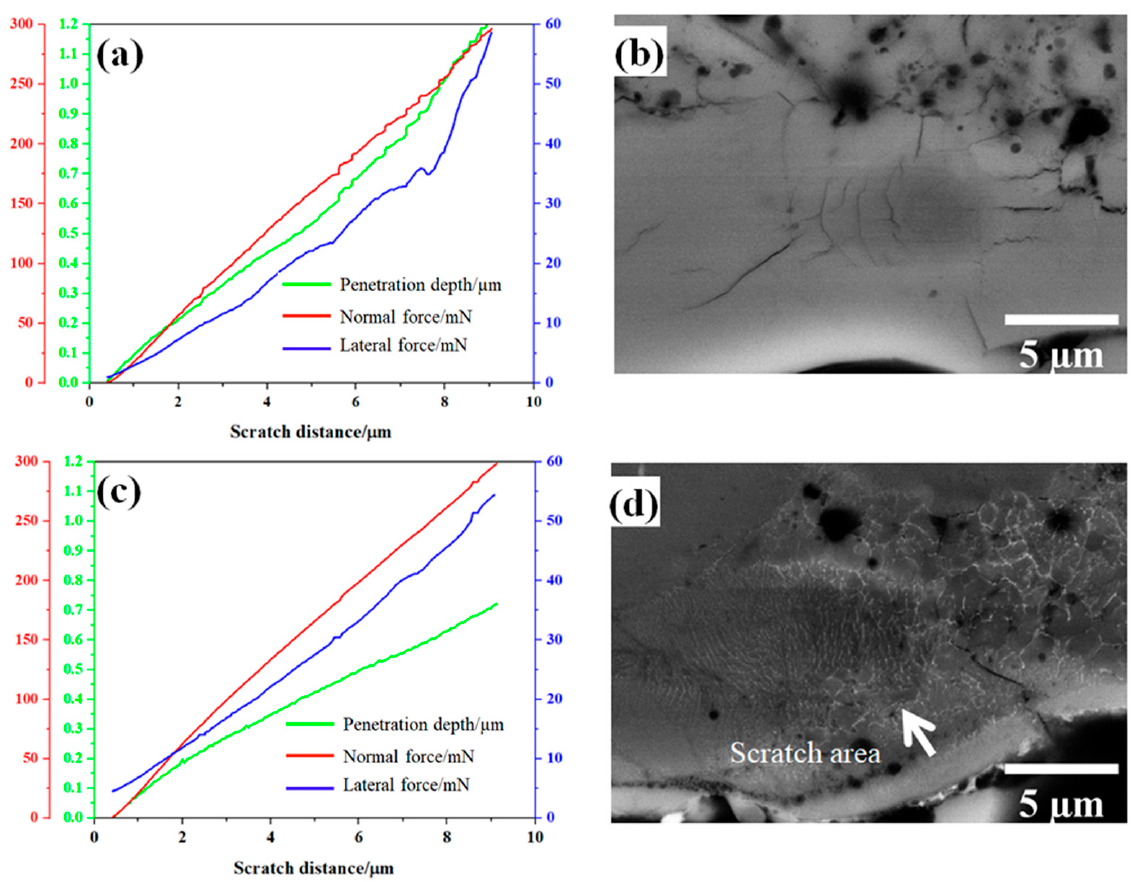
Figure 7. Nano-scratch results and BDS images of one representative scratch on the Al 2 O 3 reference coating ( a , b ) and the Al 2 O 3 -ZrO 2 coating ( c , d ).